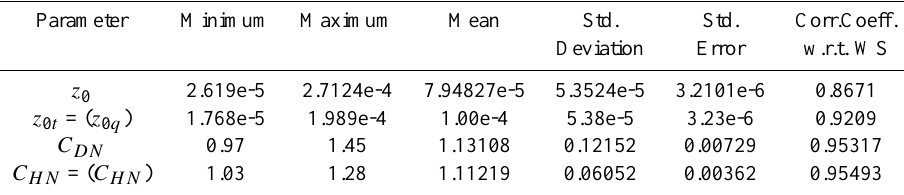
Table 3. Statistical estimates of parameters and their wind speed dependence during INDOEX,